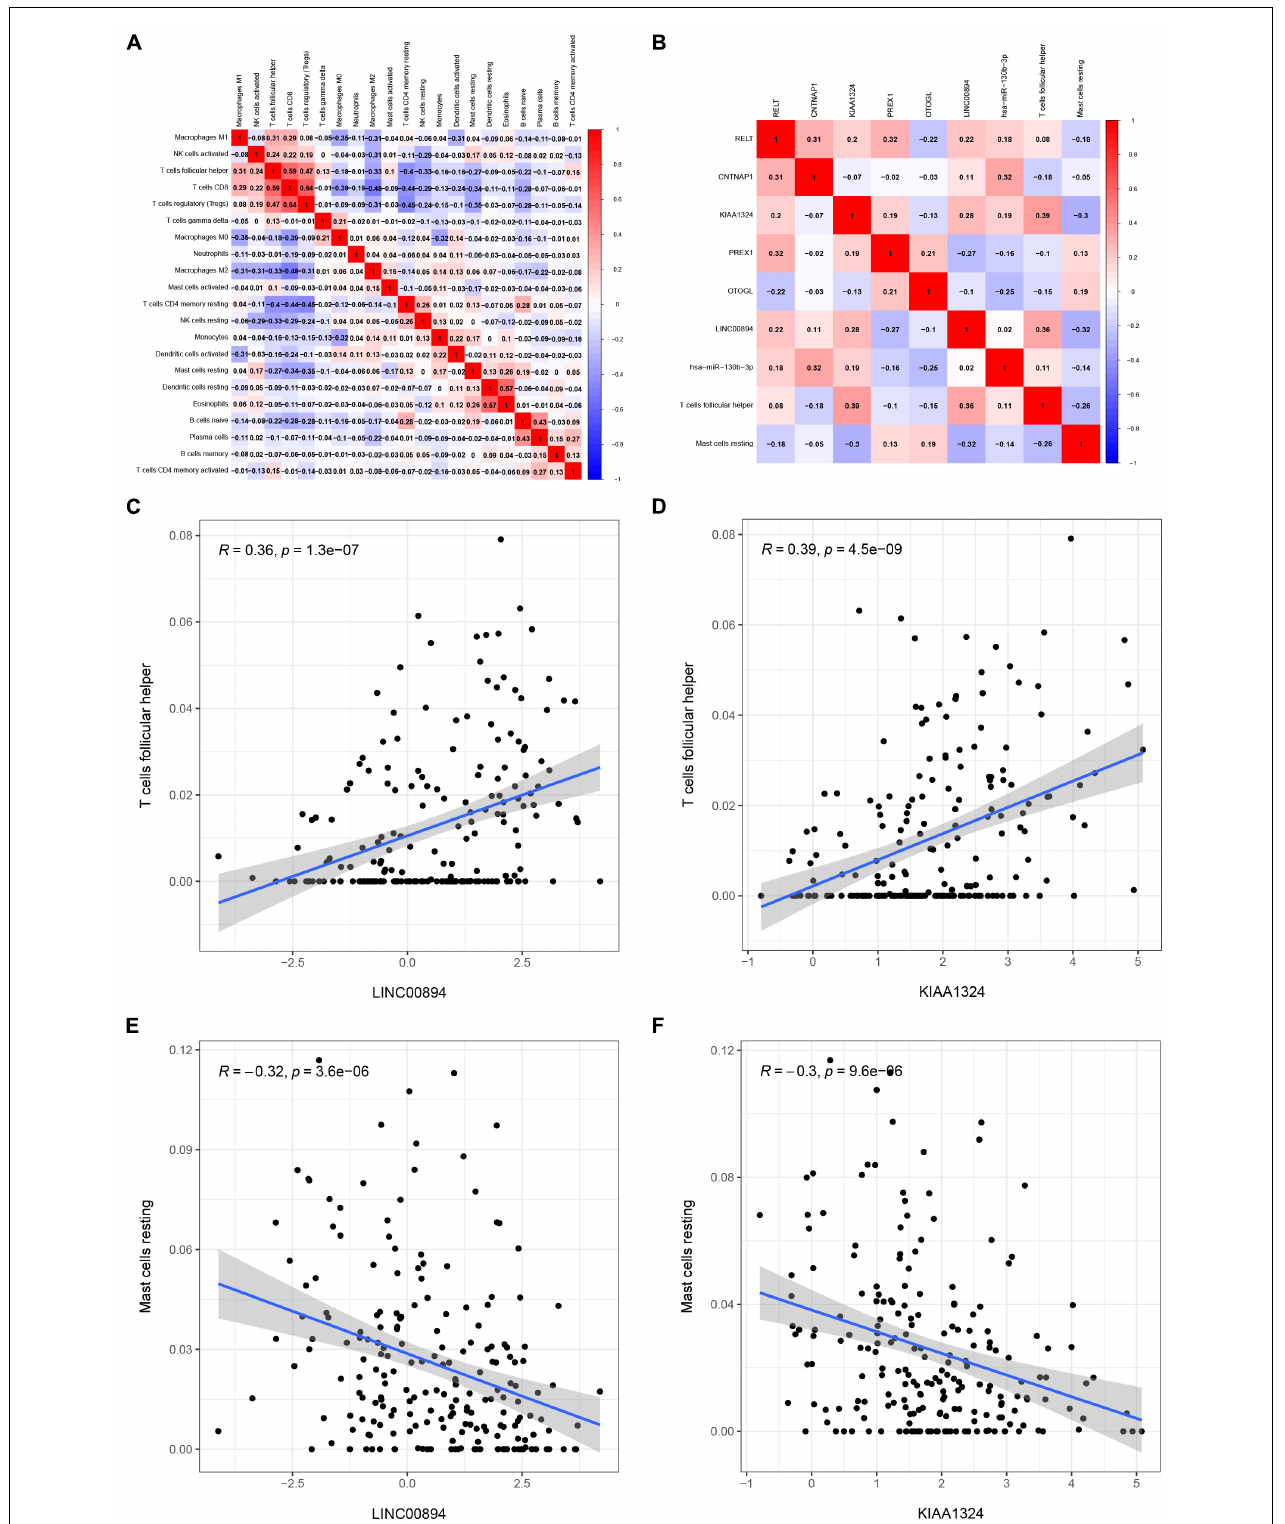
FIGURE 7 | Co-expression heatmap of all immune cells in KIRC (A) ; the co-expression heatmap of the RNAs and immune cells in the two Cox proportional hazards regression models (B) ; the significant results of Pearson correlation coefficients between the RNAs and immune cells: Tfh cells and LINC00894 (C) ; Tfh cells and KIAA1324 (D) ; resting mast cells and LINC00894 (E) ; and resting mast cells and KIAA1324 (F) .